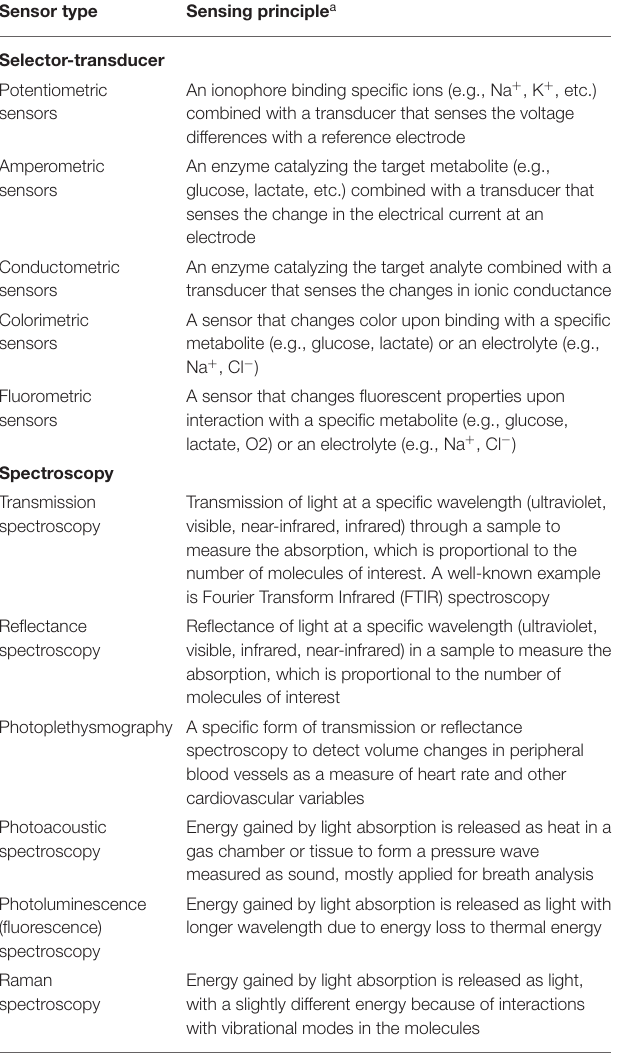
TABLE 3 | Sensor types and related sensing principles for wearable, non-invasive, continuous molecular digital